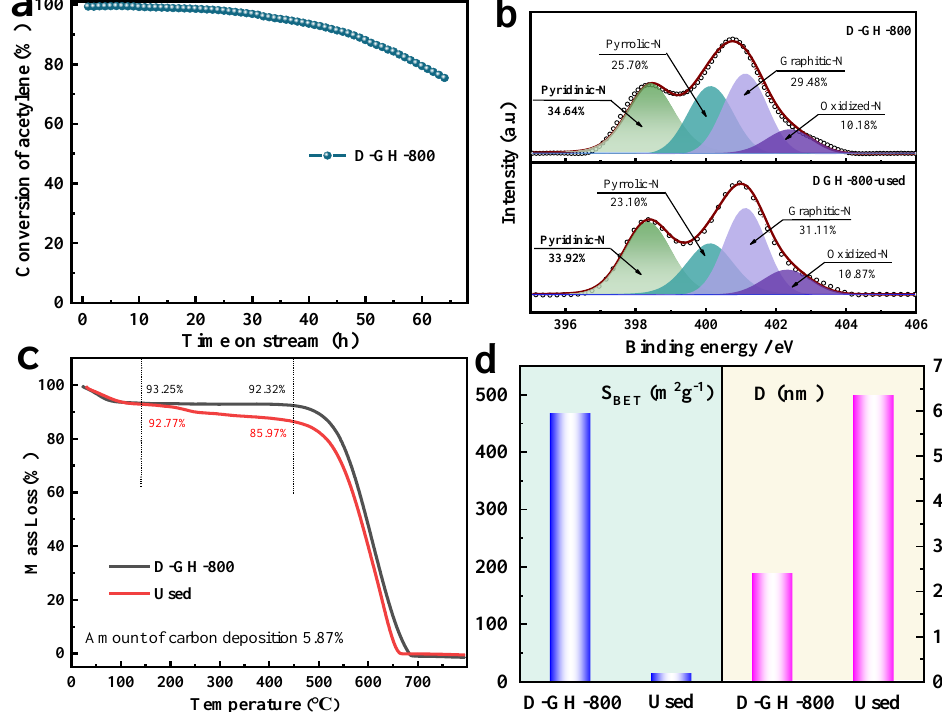
Figure 4. ( a ) The catalytic stability of D-GH-800. Reaction conditions: T = 220 °C, C 2 H 2 = 50 h − 1 , V HCl /V C2H2 = 1.15. ( b ) High-resolution XPS N1s spectra for D-GH-800 and Used. ( c ) Air-TG curves of the unreacted and reacted D-GH-800 recorded under air atmosphere. ( d ) The specific surface area data of Used and 0.5ZnCl 2 /Used-800 catalysts.